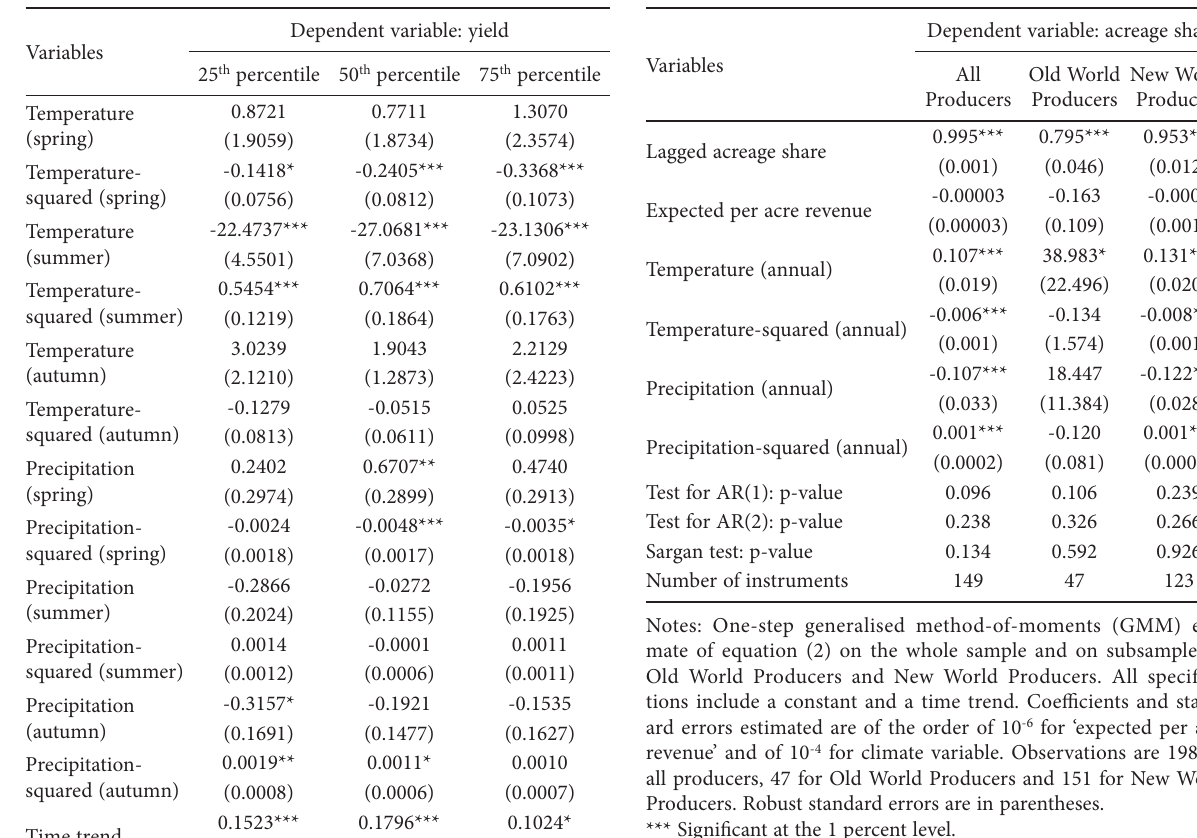
Table 3. Estimation results for grapevines yields, quantile regres- sion.